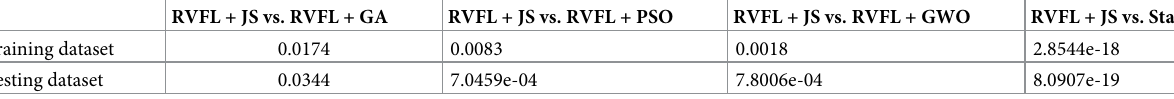
Table 12. Results from the Wilcoxon rank sum test (p � 0.05). RVFL + JS vs. RVFL +